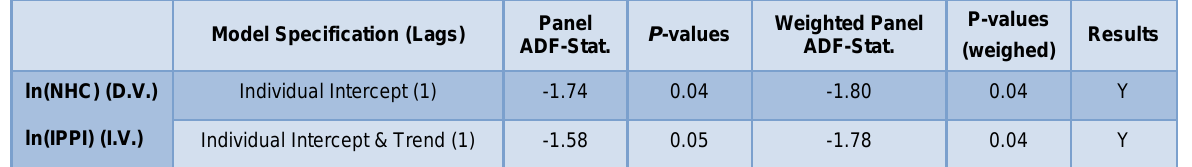
Table 2 Summary of the Pedroni cointegration test